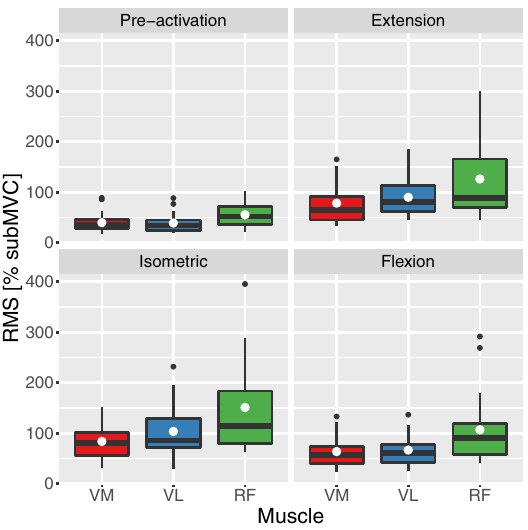
Figure 3. Neuromuscular activity per muscle and movement phase. Displayed as a boxplot with additional mean (white dot) and outliers (bold black dot). RMS root means square; subMVC submaximal voluntary contraction; VM vastus medialis; VL vastus lateralis; RF recuts